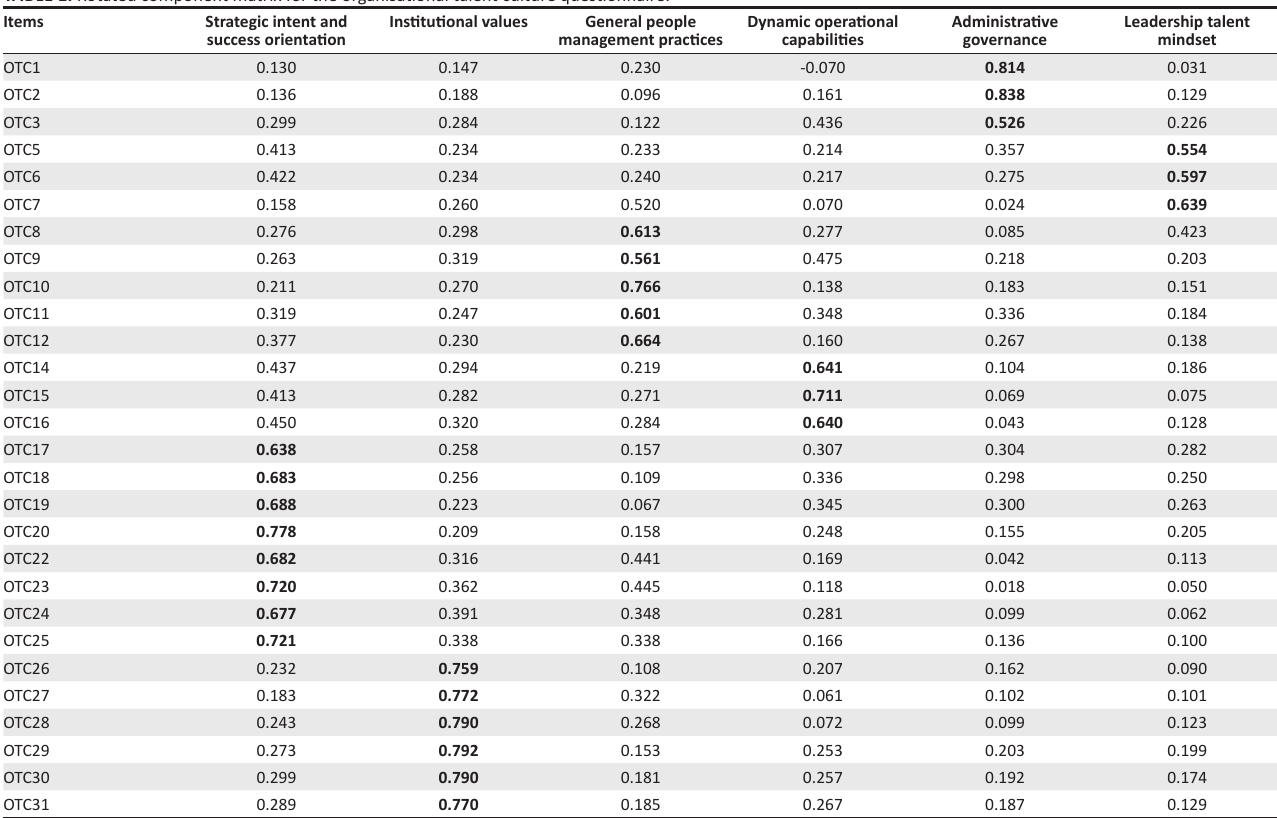
TABLE 1: Rotated component matrix for the organisational talent culture questionnaire.